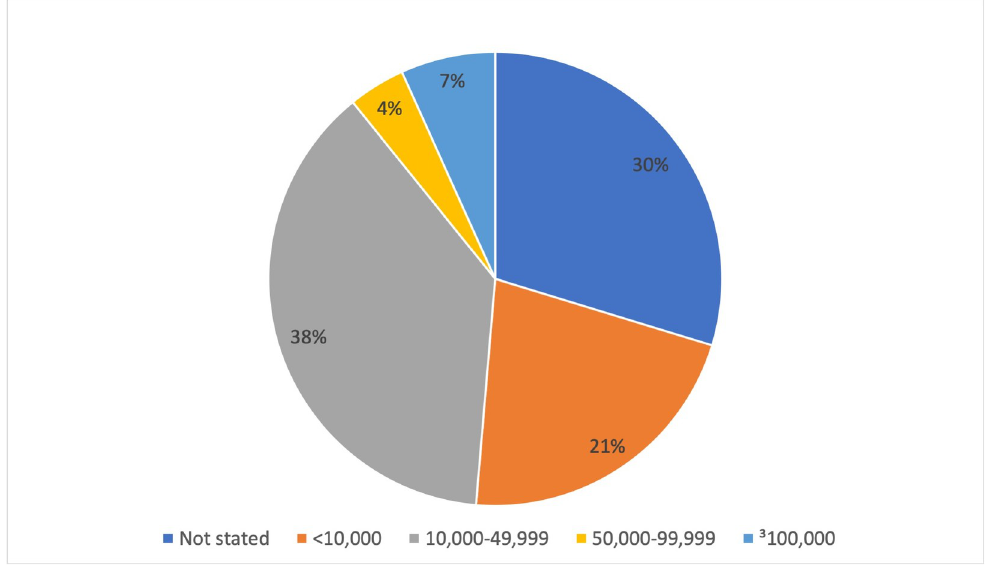
Fig 2. Value of payments for the 74 votes that involved conflicts of